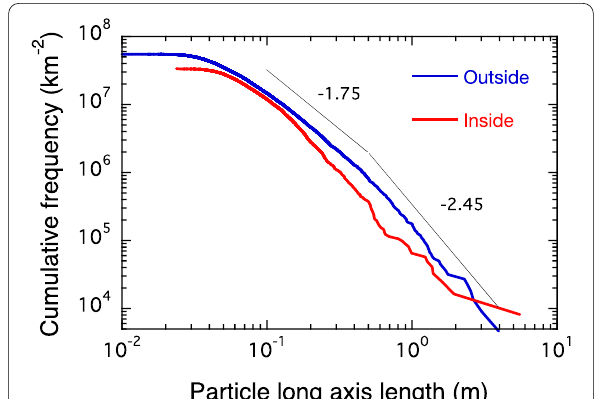
Table 2 Exponents γ and α